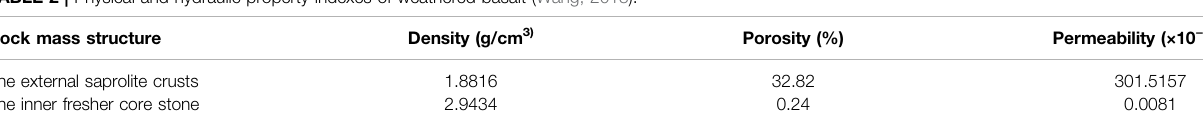
TABLE 2 | Physical and hydraulic property indexes of weathered basalt (Wang,